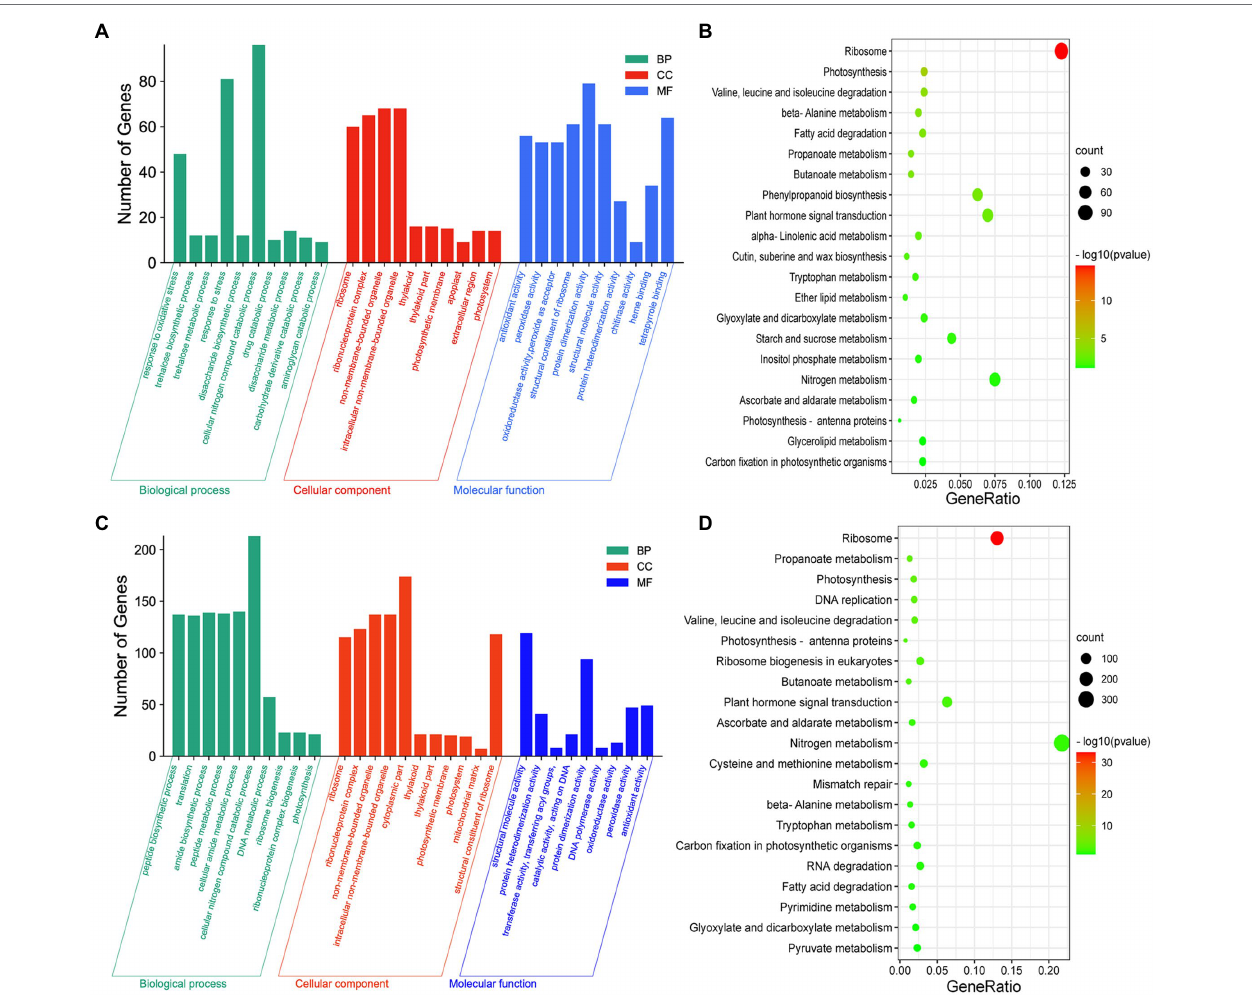
FIGURE 2 | Analysis of differential expression genes (DEGs) with different expression patterns in axillary bud under different concentrations of melatonin treatments. The GO enrichment (A) and KEGG pathway enrichment (B) analysis of DEGs at 0.1 μ m melatonin compared to 1 μ m melatonin. The GO enrichment (C) and KEGG pathway enrichment (D) analysis of DEGs at 1 μ m melatonin compared to 10 μ m melatonin. Y-axis indicates the number of GO annotated genes, and X-axis indicates the processes/components in different biological processes, cellular components, and molecular functions (A,C) . Y-axis indicates KEGG pathway, and X-axis indicates the ratio of the number of enriched genes to the number of annotated genes in the pathway (B,D) . The color of the dot represents value of p , and the size of the dot represents the number of DEGs mapped to the referent